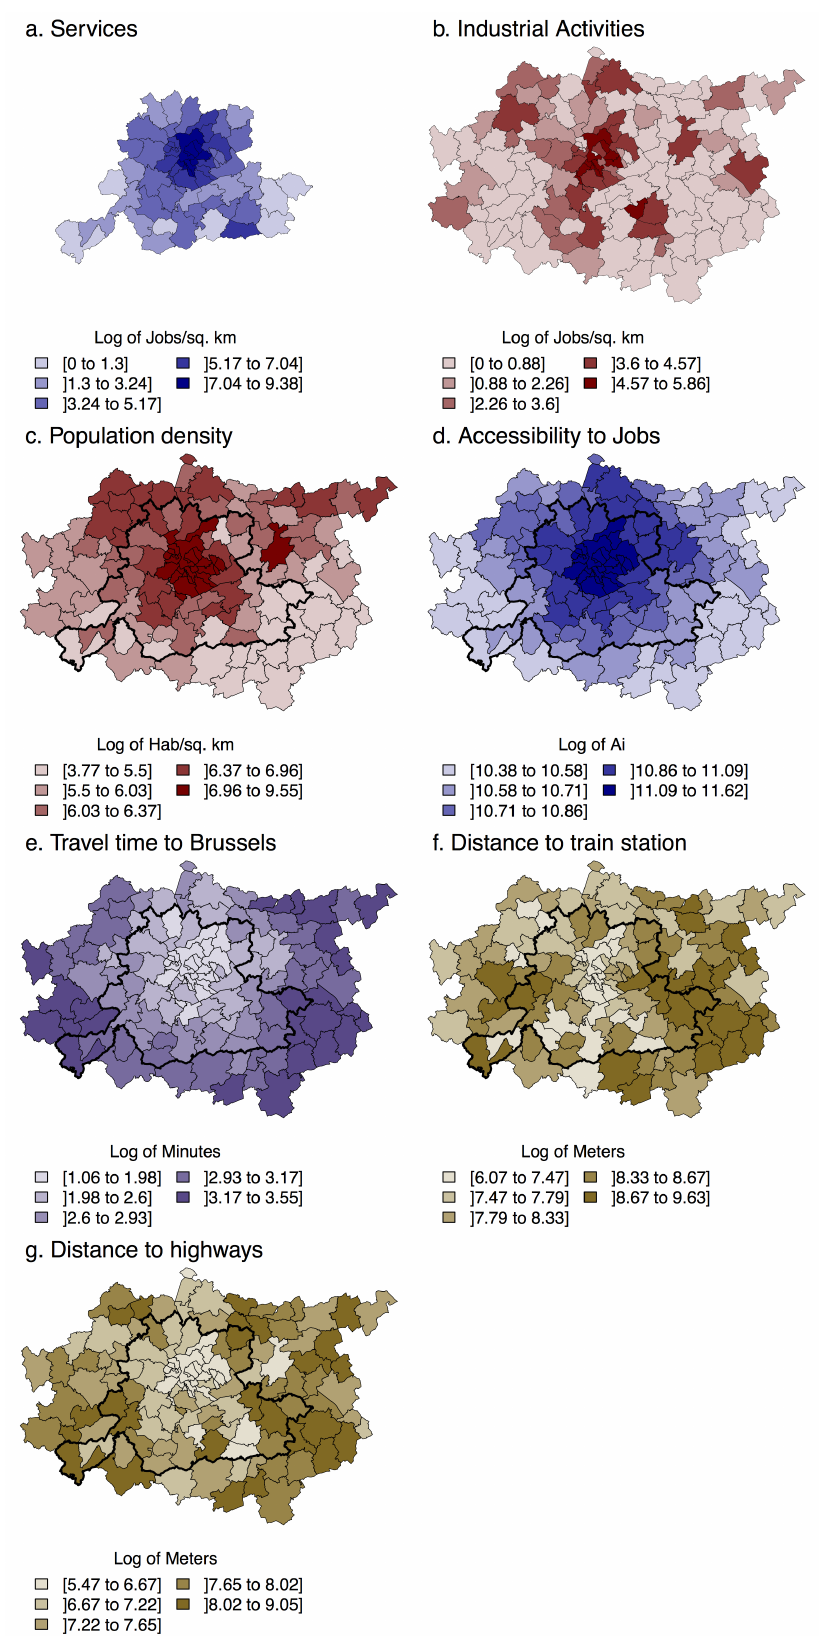
Figure 1: Variables of the location choices model, at the municipalities level (discretization: jenks)